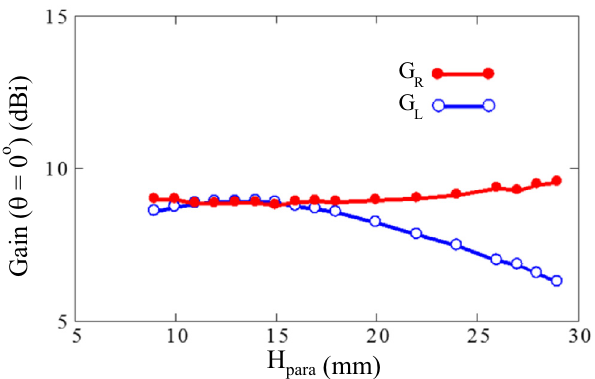
Fig. 6. G L at f = 2.58GHz and G R at 3.51GHz as a function of parasitic loop (paraloop) height H para , where w para = 2mm and L para = 116.7mm ( ≈ 1 l 0 at 2.58GHz) are used.